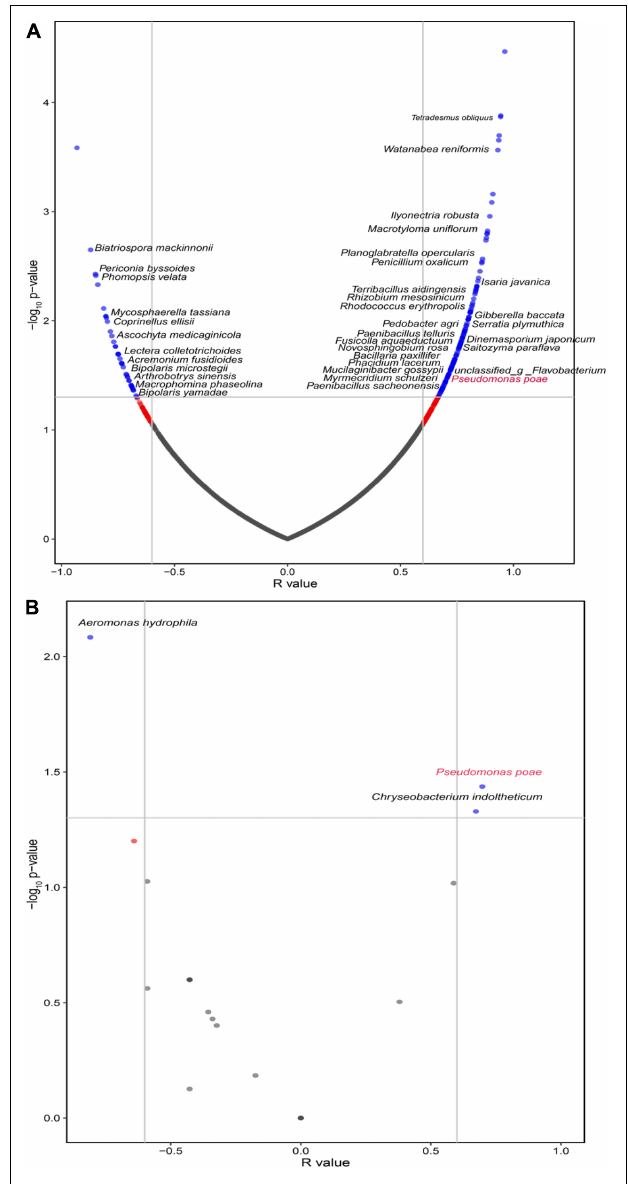
FIGURE 4 | The volcano plot for correlations between F. oxysporum and the microbial community in the (A) rhizosphere and (B) endosphere of the tuberous roots. The green points represent significantly correlated species (Sparcc, r > 0.6, P < 0.05).